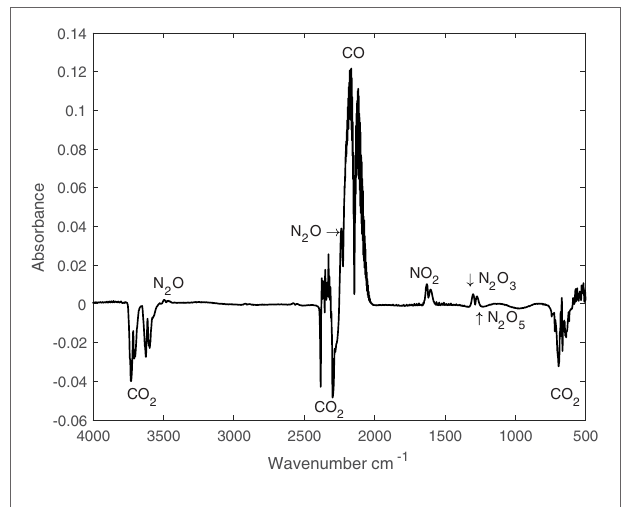
FigUre 7 | Sample Fourier transform infrared absorbance spectrum subtracted from background spectrum for 50:50 CO 2 :N 2 mixture.